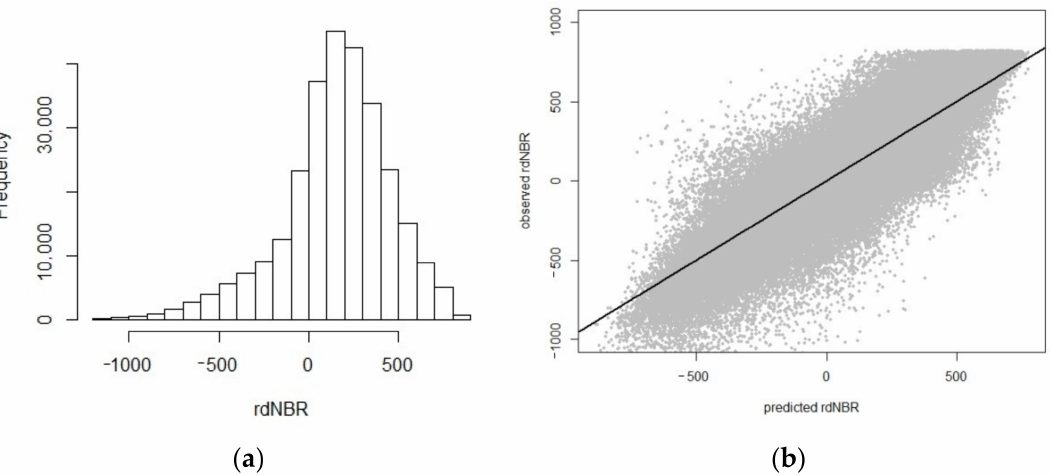
Figure 4. Histogram of rdNBR values (( a ), calculated using the fire perimeters within the study area during the period 2004–2017; ONF and CFS datasets) and predicted versus observed rdNBR (( b ), Pearson correlation coefficient